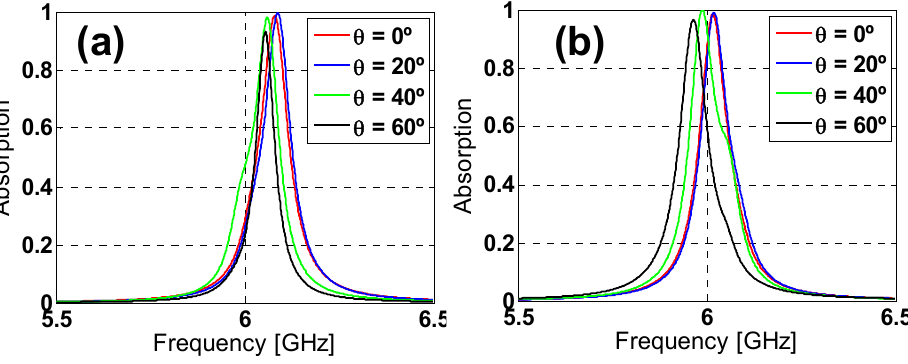
Figure 11. Star design absorption in simulation with Arlon25N and different incident angles ( θ ) for both ( a ) TE and ( b ) TM